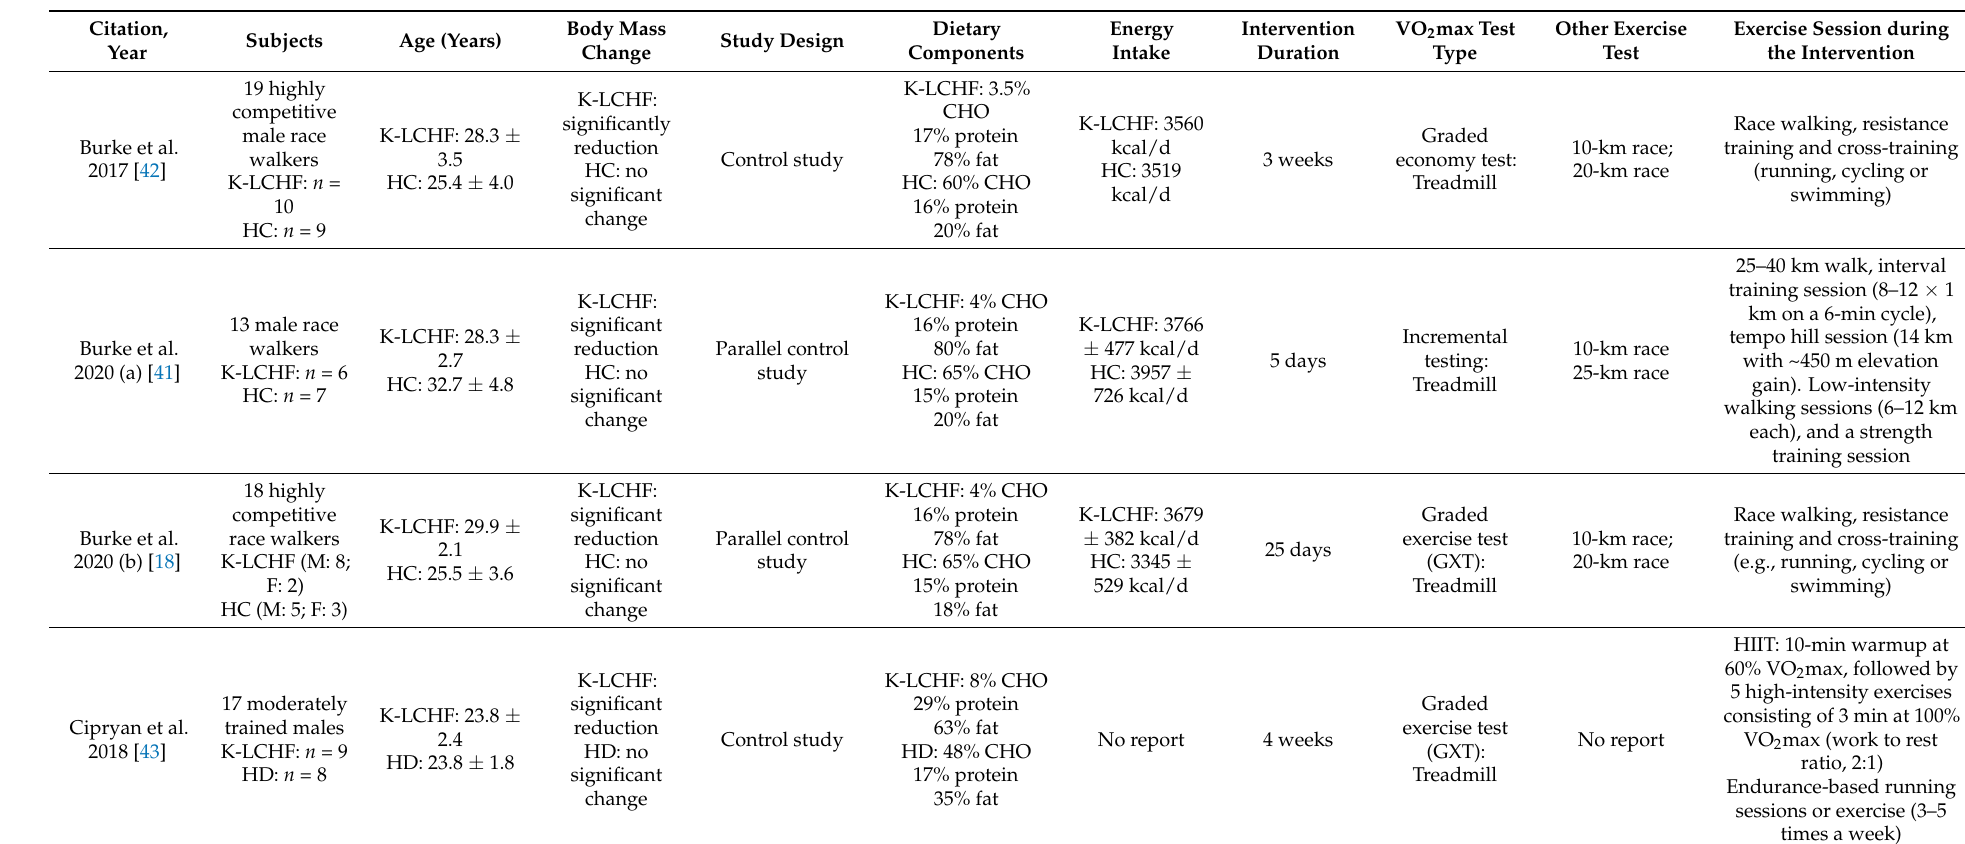
Table 1. Characteristics of included